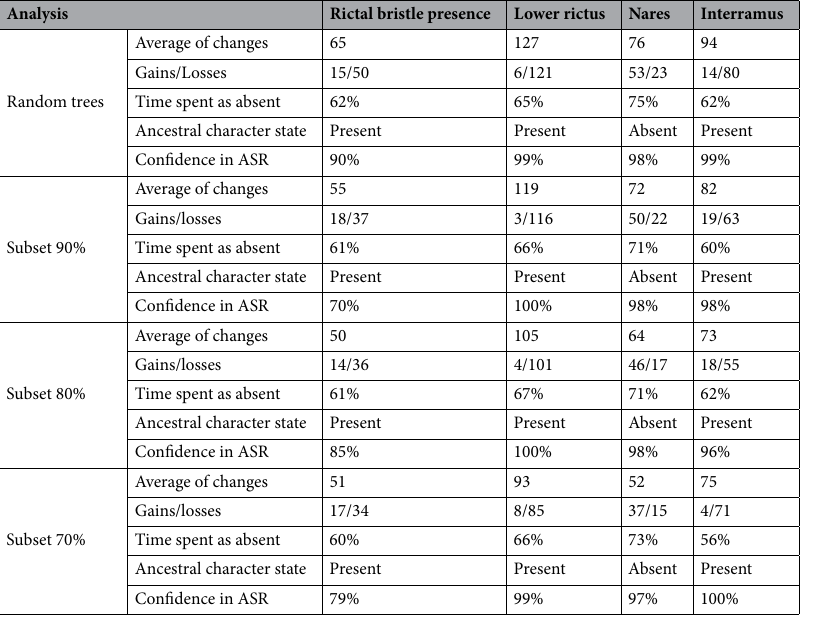
Table 2. Sensitivity analysis results for rictal bristle presence: mapping of the stochastic character on 100 trees randomly sampled from the posterior distribution over 100 simulations, and mapping of the stochastic character with each weighted downsampled subsets (70%, 80%,